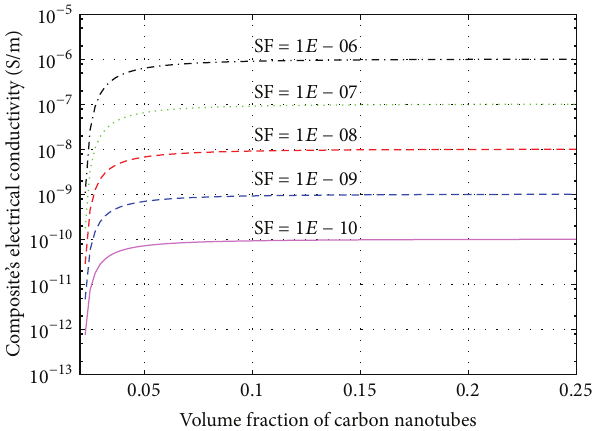
Figure 17: DC electrical conductivity of the nanocomposite at varying the conductivity at the percolation threshold (Mamunya’s